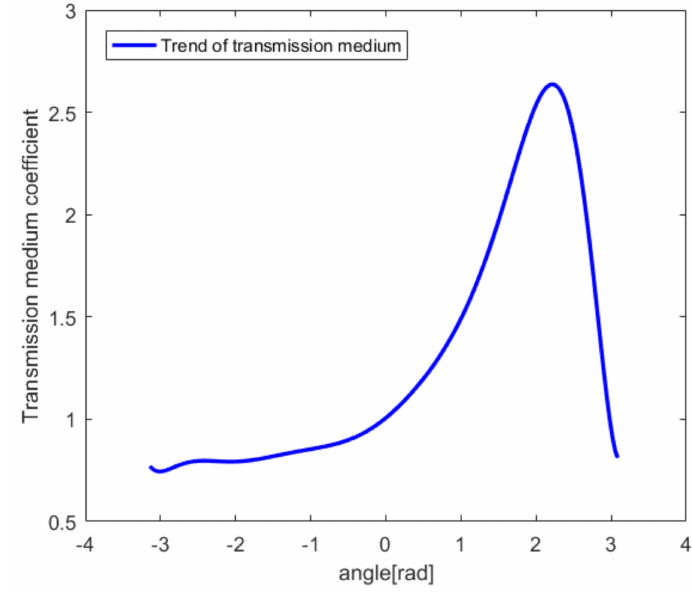
Figure 18. The transmission medium coe ffi cient (TMC) curve.